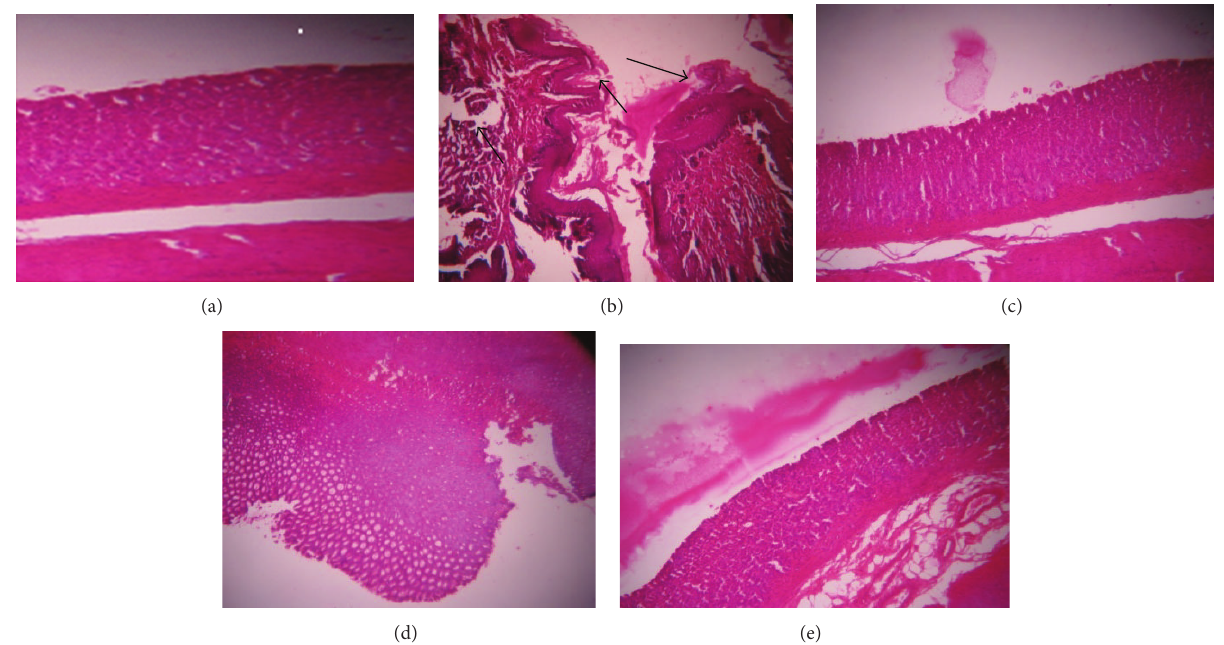
Figure 4: Light microphotographs of cross-sections of mouse skin. (a) Group 1: mouse received normal water demonstrating normal histological architecture,H&E, 400X. (b) Group 2: mouse topical exposure to DMBA + croton oil demonstrating damage (→) in dermal layer. H&E. 400X. (c) Group 3-mouse oral and topical exposure to palmatine for 16 weeks showing normal histological architecture. H&E. 400X. (d) Group 4: mouse oral (palmatine 100mg/kg) and topical (DMBA + croton oil) exposure showing some normal histological architecture, H&E, 400X. Group 5: mouse oral (palmatine 200 mg/kg) and topical (DMBA + croton oil) exposure showing normal histological architecture,H&E,